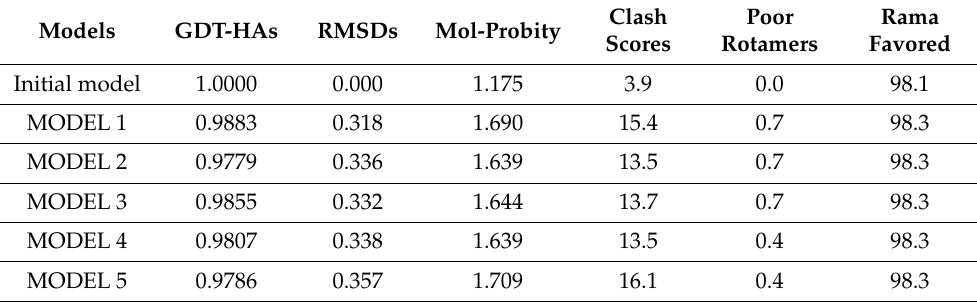
Table 5. The selection of an initial model for further analysis was based on obtained scores in comparison to the other five models generated by GalaxyRefine server. This was also reflected by the lower Rama favored score obtained for the initial model with little deviation in comparison to other five models. Similarly, higher scores in other parameter let us make the final selection of initial model for